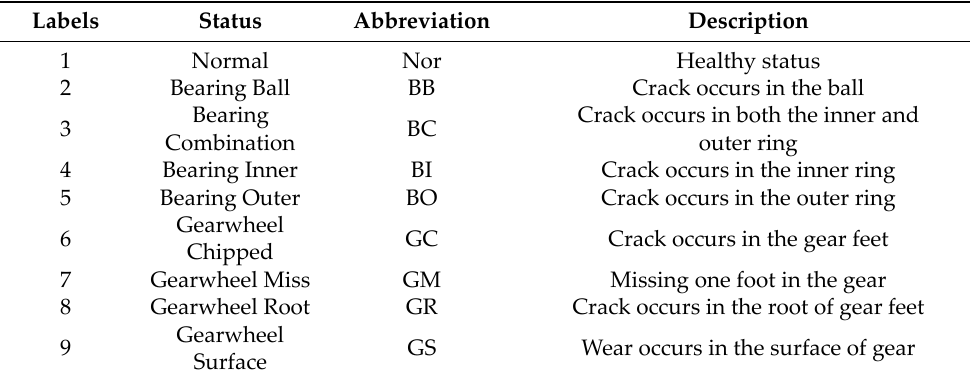
Table 12. The detailed fault information of gearbox